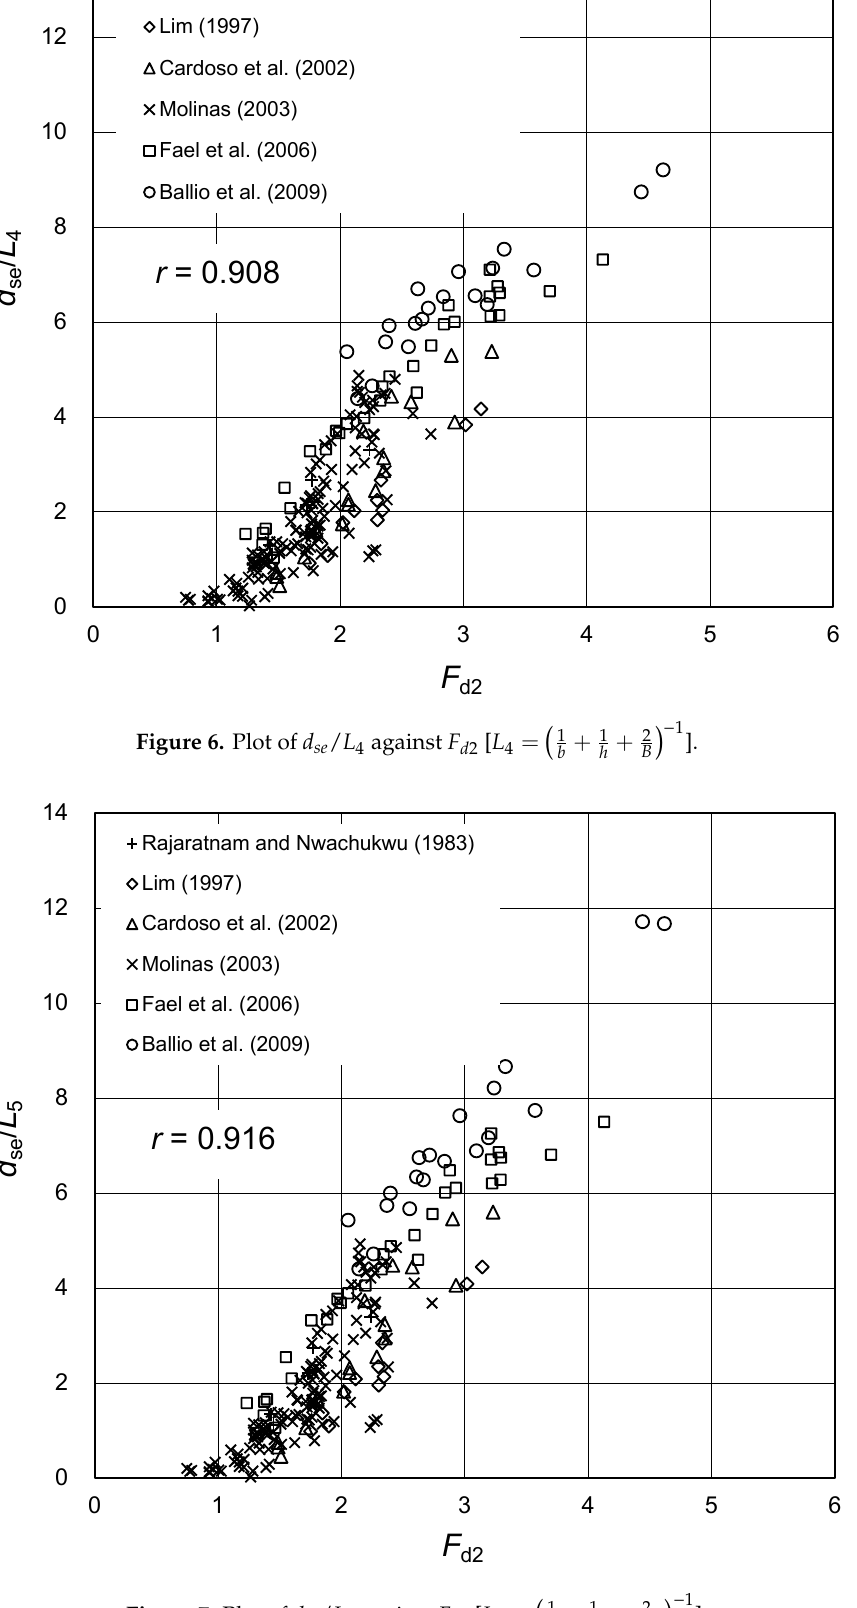
Figure 7. Plot of d se / L 5 against F d 2 [ L 5 =